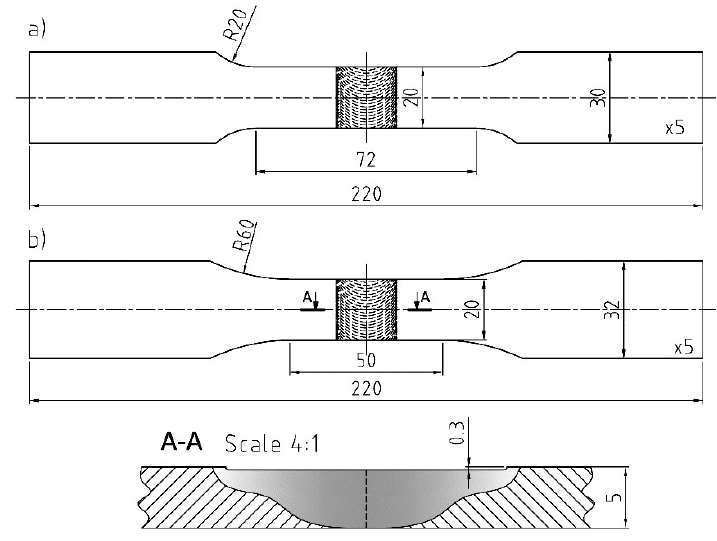
Figure 3. Specimen geometry used in static tests ( a ) and fatigue tests ( b ) (dimensions in mm).